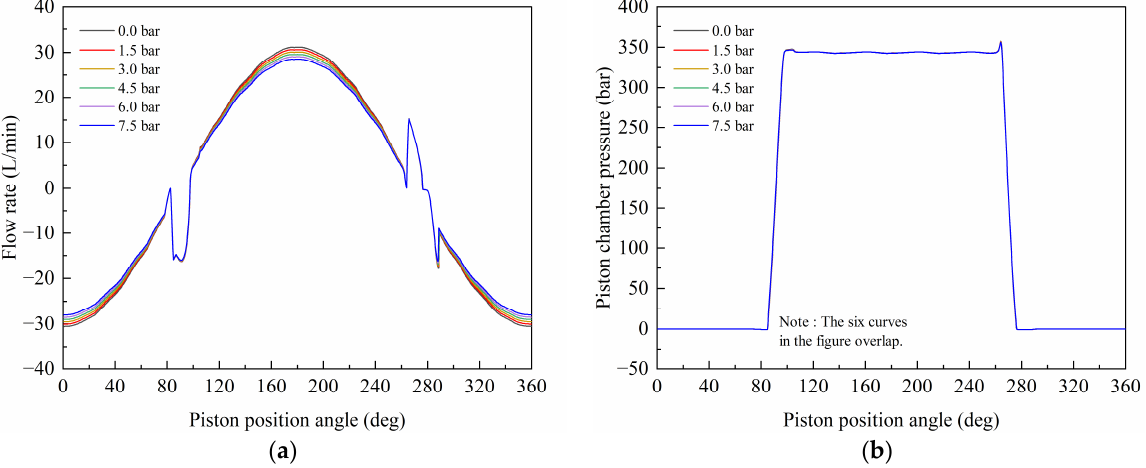
Figure 30. Flow and pressure characteristics of the piston chamber under different power control pilot pressures: ( a ) dynamic flow; ( b ) dynamic